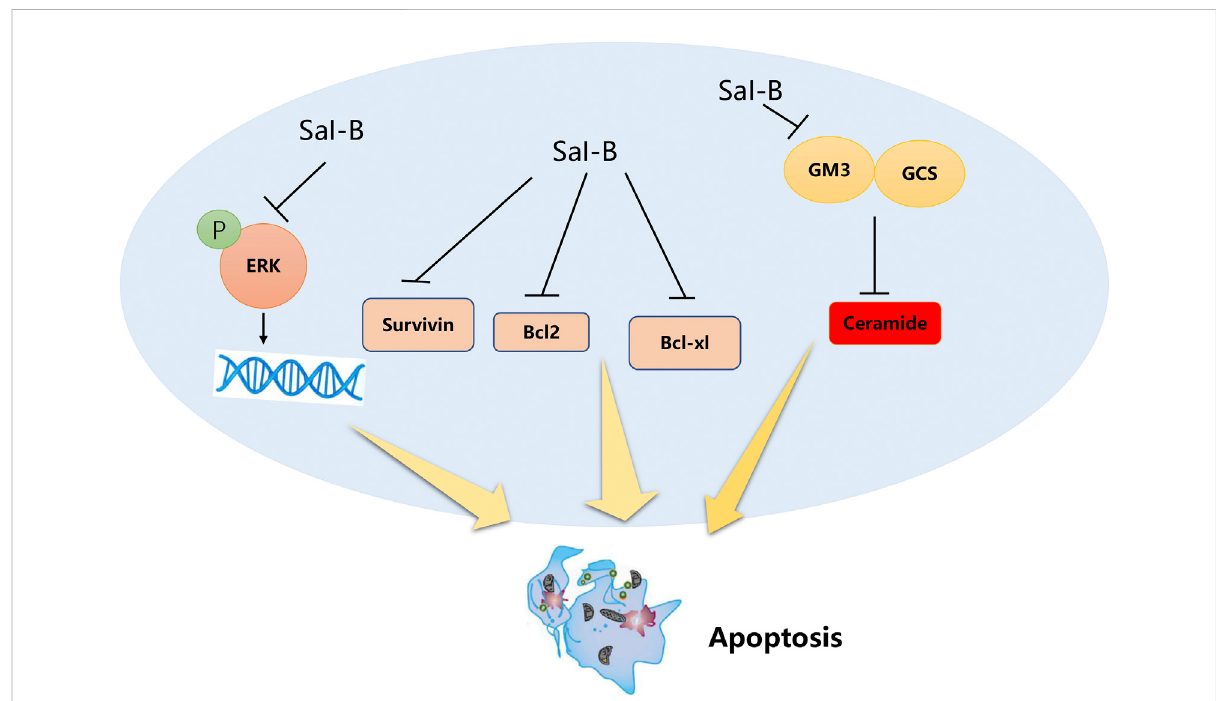
FIGURE 3 Sal-B inhibits Bcl-2, Bcl-xl, Survivin, glucosylceramide, and GM3 synthase expression, inducing ceramide-mediated apoptosis in breast cancer cells (Extracellular regulated protein kinases, ERK; B-cell lymphoma-2, Bcl-2; B-cell lymphoma – extra-large, Bcl-xl; ganglioside M3, GM3; glucosylceramide,